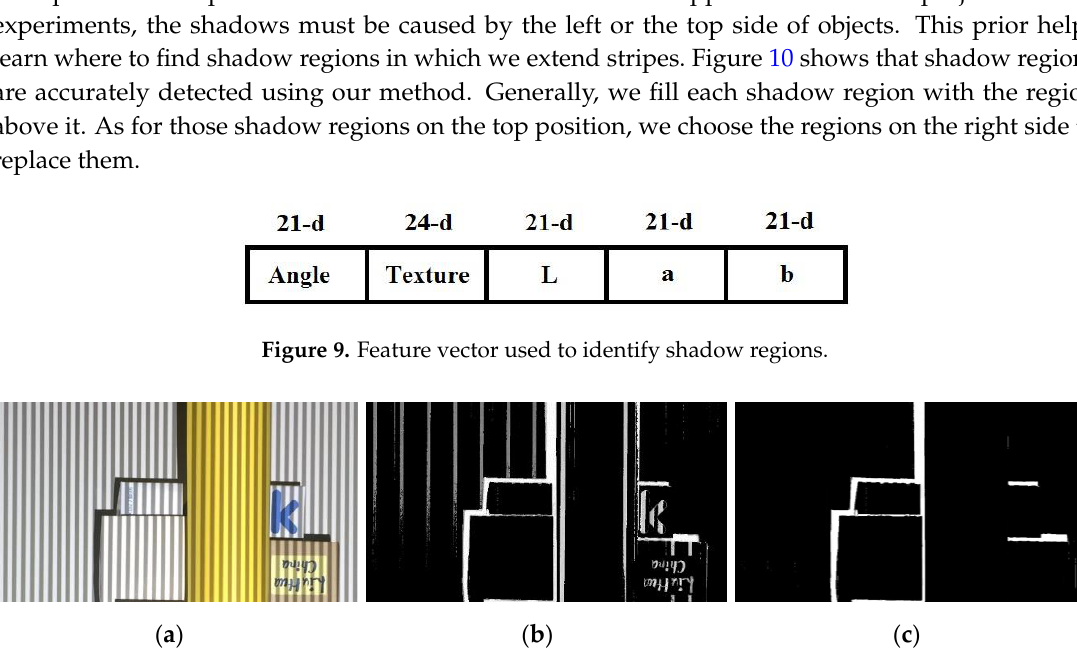
Figure 10. Detection of shadow regions: ( a ) camera’s view of the scene; ( b ) cosine value of angle between 𝑂𝐵⃗⃗⃗⃗⃗ and 𝑂𝐶⃗⃗⃗⃗⃗ ; ( c ) shadow regions detected using the feature vector in Figure 9.